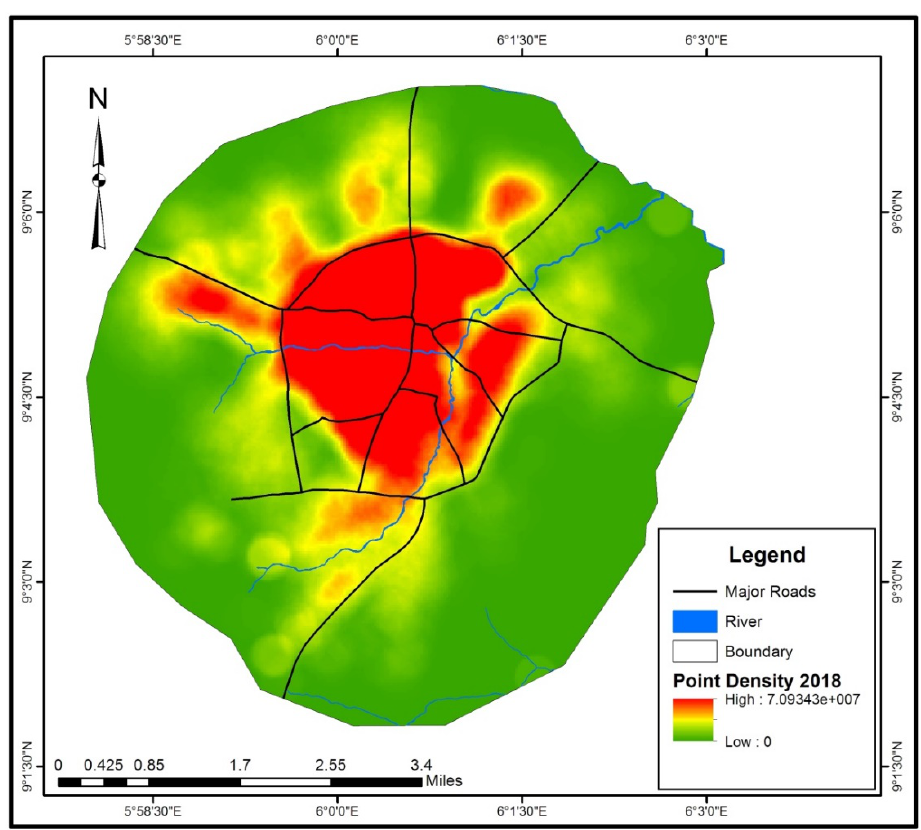
Fig. 5. Spatial pattern of residential density in the study area in 2018 (Developed by the authors,